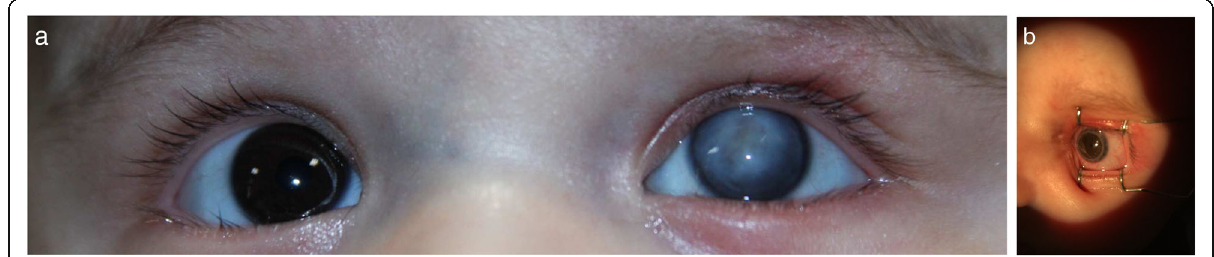
Fig. 1 An infant presented with corneal thinning and diffuse infiltration related to Pseudomonas aeruginosa keratitis due to nail trauma, the patient underwent amniotic membrane transplantation as a tectonic procedure, a shows full thickness corneal scar one month later. b shows clear optical graft four weeks after corneal